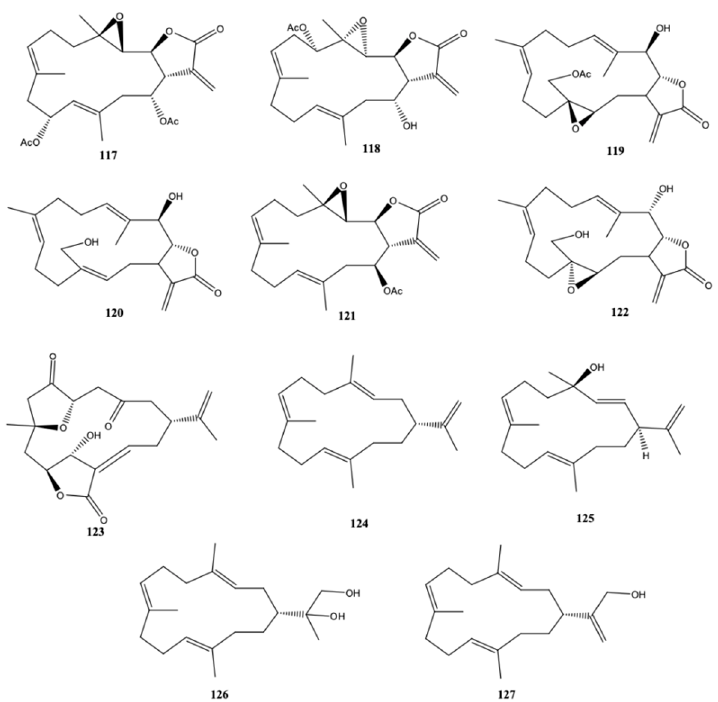
Figure 12. Cembranoid diterpene derivatives isolated from Sinularia compacta from the South China Sea (Tongguling National Nature Reserve of Coral Reefs) [38].